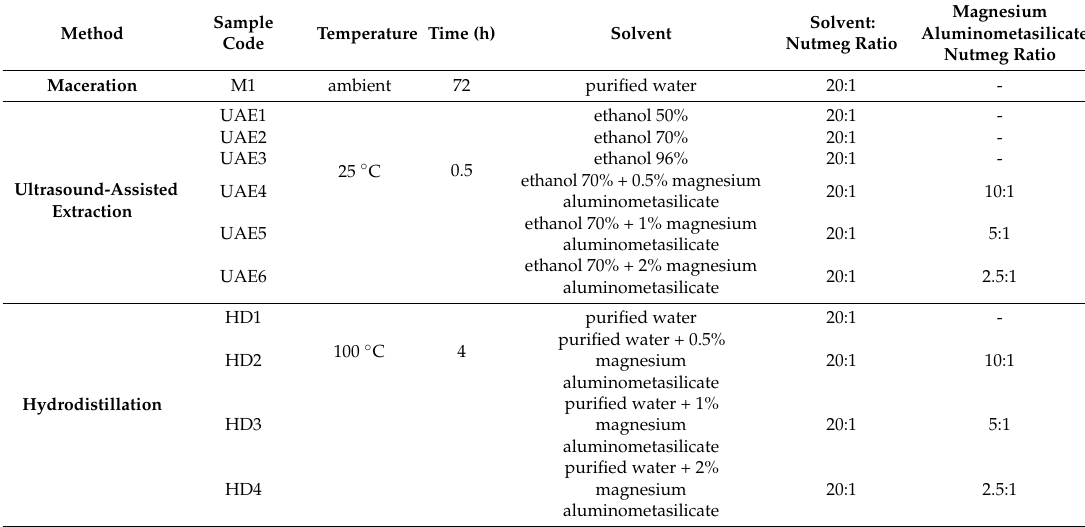
Table 1. Extraction conditions used for each